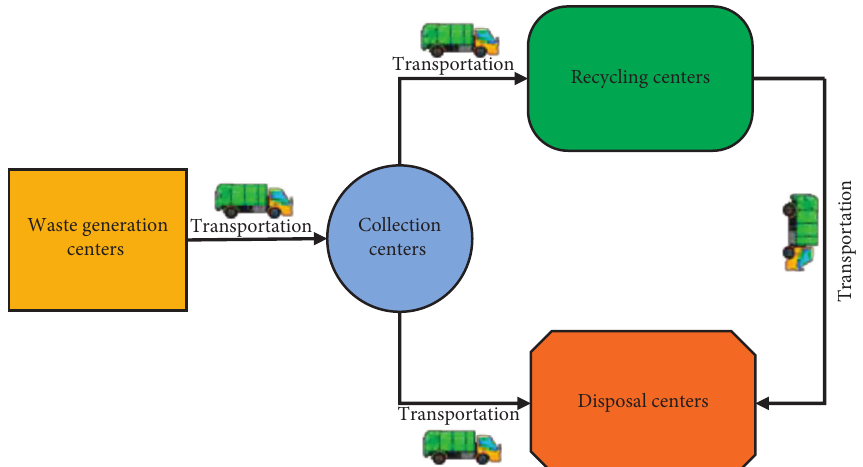
Figure 1: Proposed network for an efficient MSW